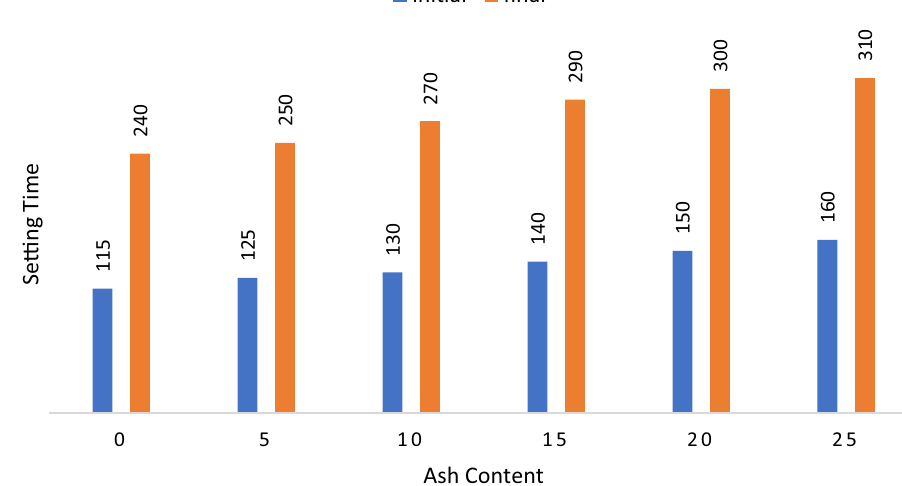
Fig. 2 Review methodology flowchart